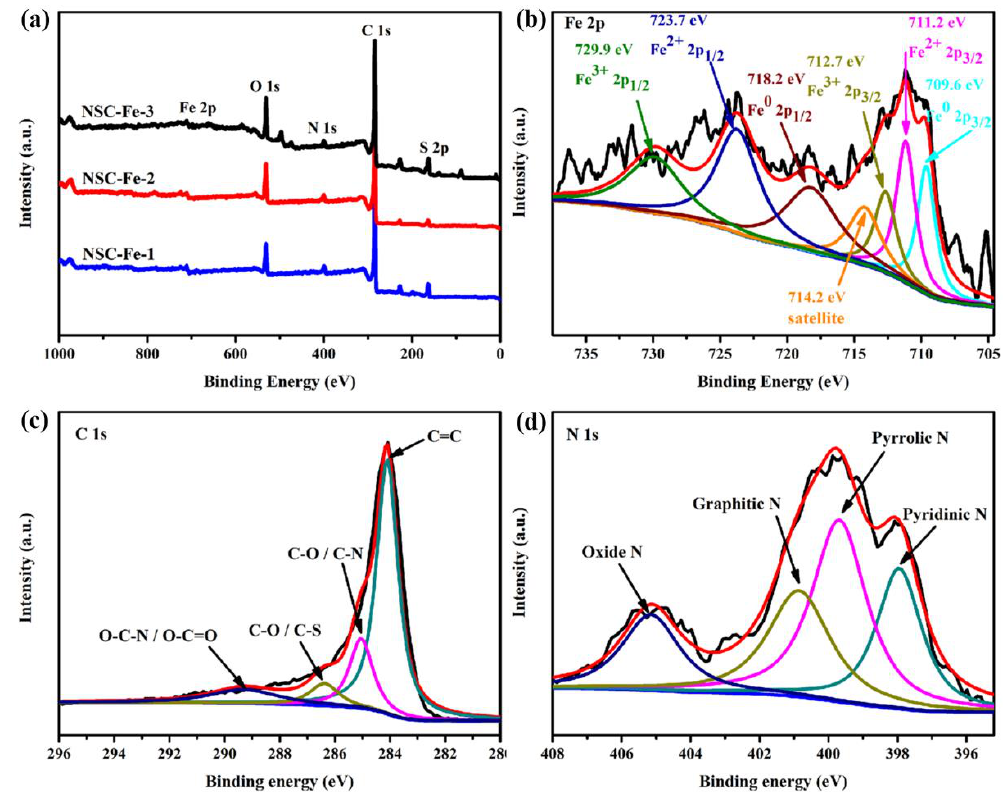
Figure 4. ( a ) X-ray photoelectron spectroscopy (XPS) survey scans of NSC-Fe- x . ( b ) Fe 2p XPS spectrum of NSC-Fe-2, ( c ) C 1s XPS spectra of NSC-Fe-2, and ( d ) N 1s XPS spectra of NSC-Fe-2.